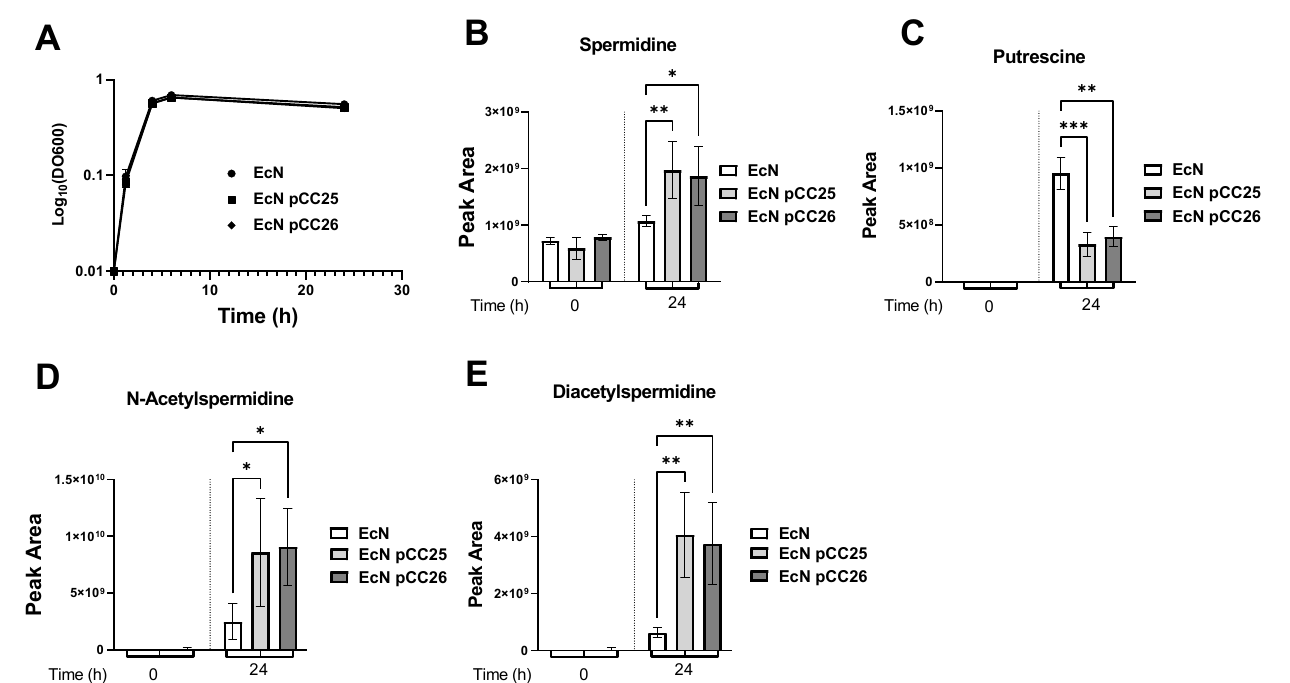
Figure 2. Production of spermidine by EcN pCC25 and EcN pCC26 compared to the wild type EcN. ( A ) Growth curves of EcN, EcN pCC25 and EcN pCC26 in LB medium (n = 8). ( B – E ) Peak area of spermidine ( B ), putrescine ( C ), N-acetylspermidine ( D ) or diacetylspermidine ( E ) measured by LC-MS in the culture supernatant of EcN, EcN pCC25 and EcN pCC26 at the beginning of the culture (0) or 24 h after the cultivation start (24) (n = 8). The individual data were obtained from independent cultures. All data shown represent the mean ± SD. Statistical significance was calculated using Kruskal–Wallis test and Benjamini, Krieger and Yekutieli Multiple comparisons. Statistical significance indicated as * p < 0.05, ** p < 0.01, *** p < 0.001.